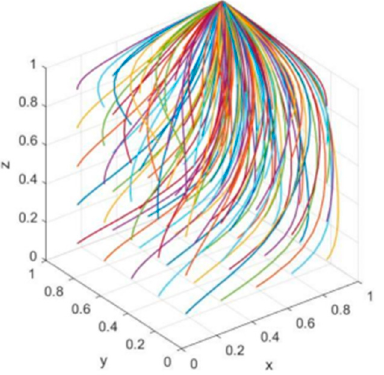
Figure 4. Evolutionary simulation at the initial stage point (1, 0, 1).